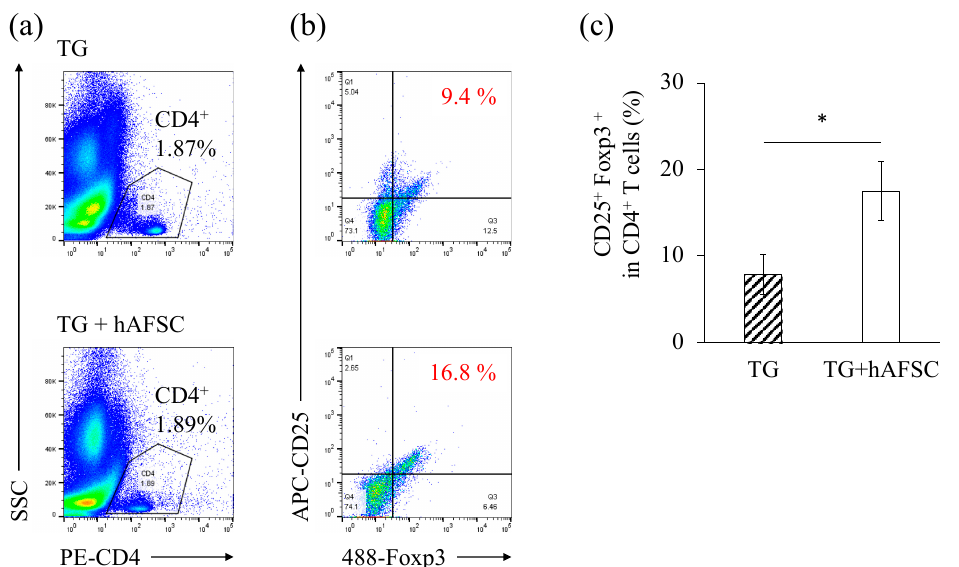
Figure 5. Regulatory T cell (Treg) analysis of the lavaged cells. Ratio of CD4 + CD25 + Foxp3 + Tregs. ( a , b ) The gating strategy used is shown. ( c ) The proportion of CD4 + CD25 + Foxp3 + Tregs is shown as a graph ( n = 5). The data are shown as the means ± SEM. Significance was determined by the Student’s t test. * p < 0.05.